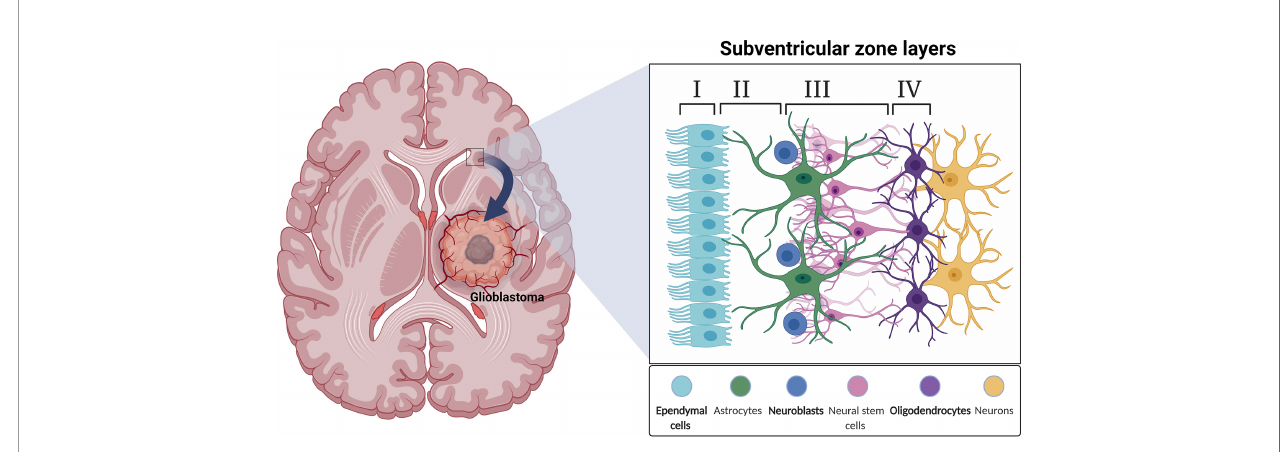
FIGURE 1 | A schematic illustration depicting a coronal view of the subventricular zone (SVZ) neurogenic niche in the adult human